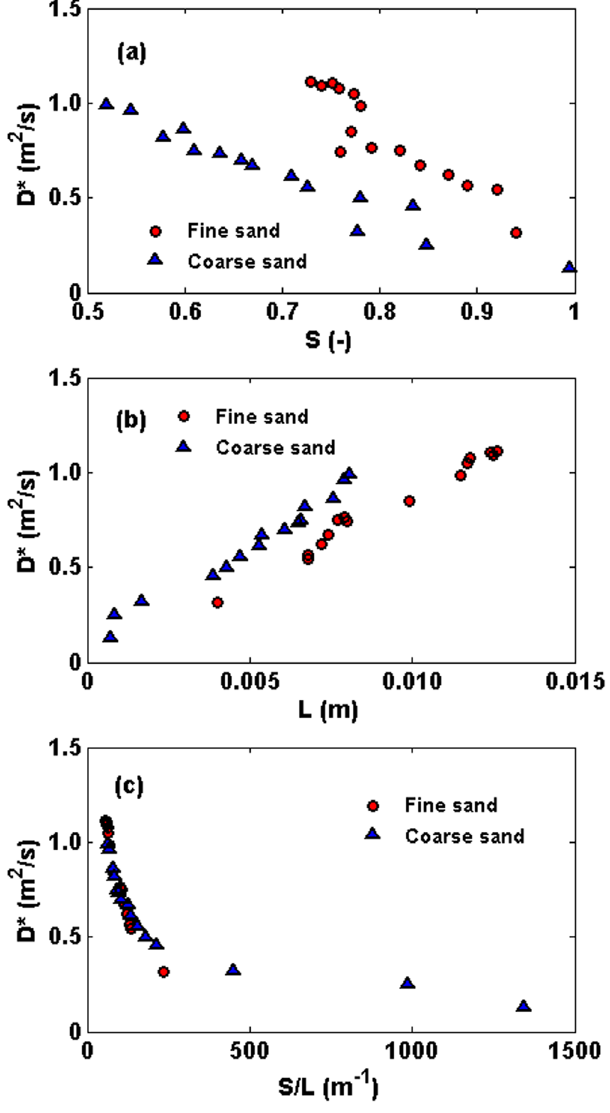
Figure 5. The variation of D * versus ( a ) the average saturation of the invaded zone S , ( b ) length of the invaded (or unsaturated) zone L and ( c ) S/L